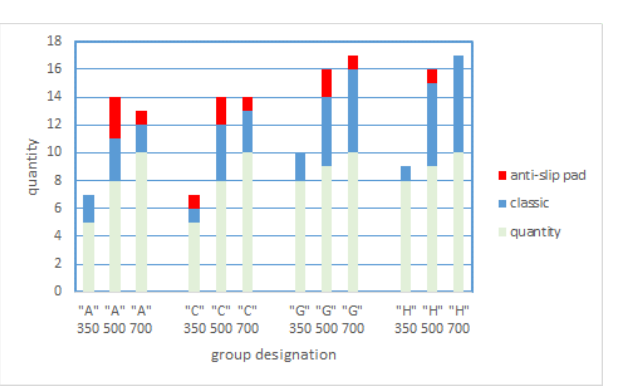
Figure 15. Illustration of the conducted tests: ( A ) — checking the resistance of the pallet to free fall; ( B ) — checking the di- mensions of the pallet; ( C ) — check: new pallet inspection staples/pallet repair authenticity nail nail; ( D ) — checking the